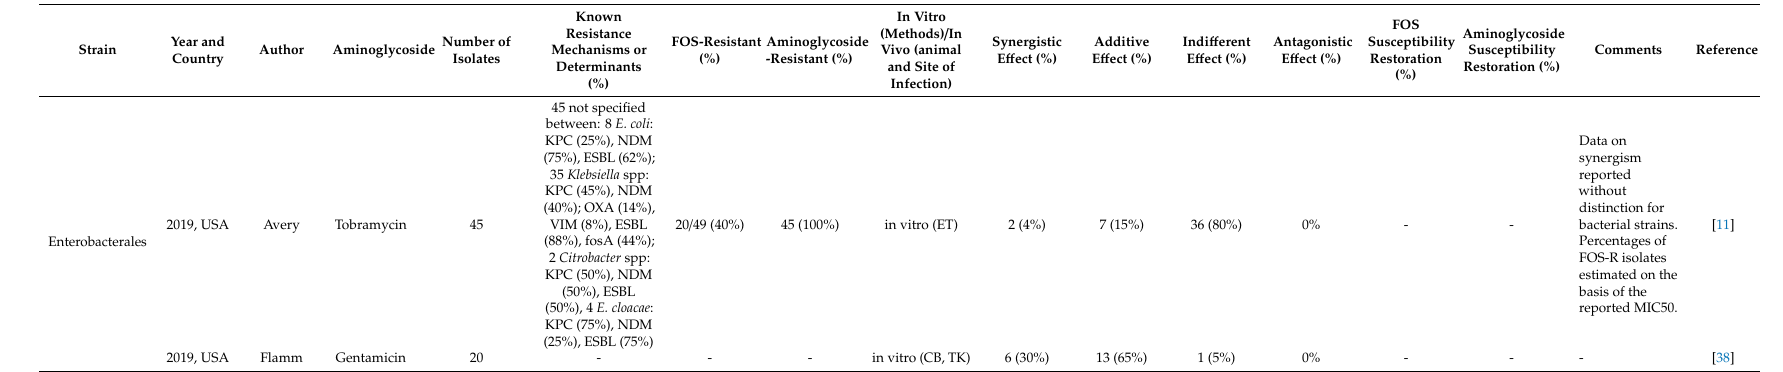
Table 6. Studies on combination between fosfomycin and aminoglycosides. CB: checkerboard assay; TK: time–kill assay; ET: